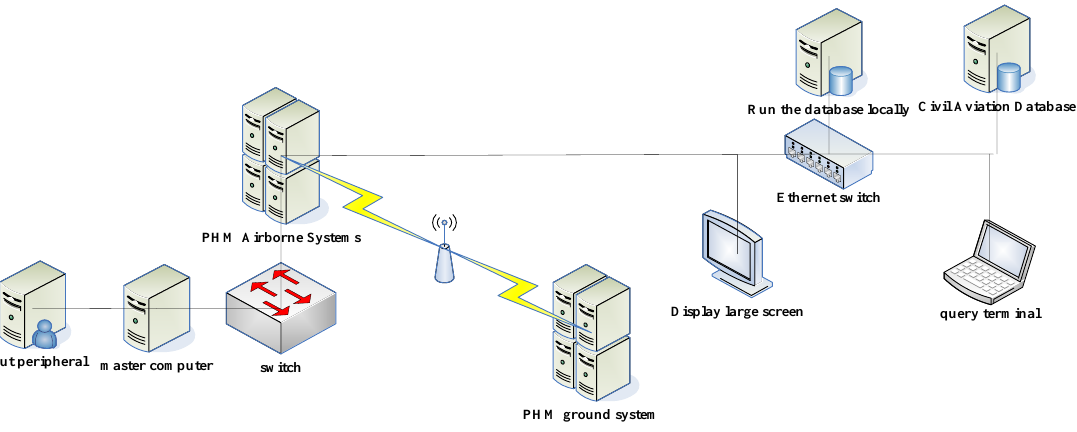
Figure 1. PHM system.